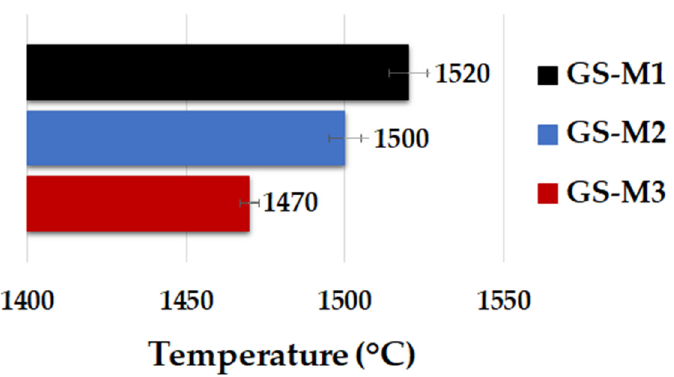
Figure 7. Pyrometric cone refractoriness of geopolymer composites with different types of aluminosilicates.